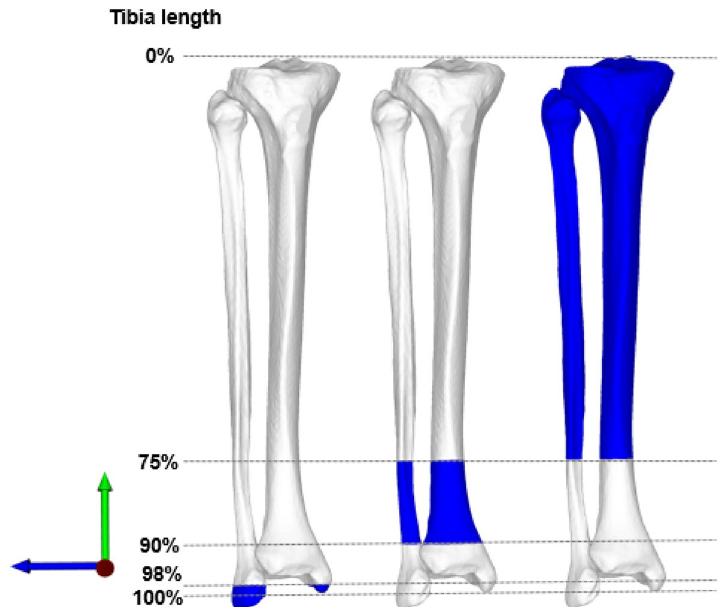
Fig. 1 Definition of segments for ankle joint line approximation. Three anatomical segments (blue) were defined for registration and depicted from left to right. Distal (left model): defined at 98% of the tibia length and the corresponding fibula. Middle (center model): Defined from 75–90% of the tibia length and corresponding fibula. Proximal (right model): The segment was defined from 0 to 75% of the tibia length and the corresponding fibula. Coordinate system depicted: z-axis (green arrow), x-axis (blue arrow), y-axis: (red arrow facing the reader)